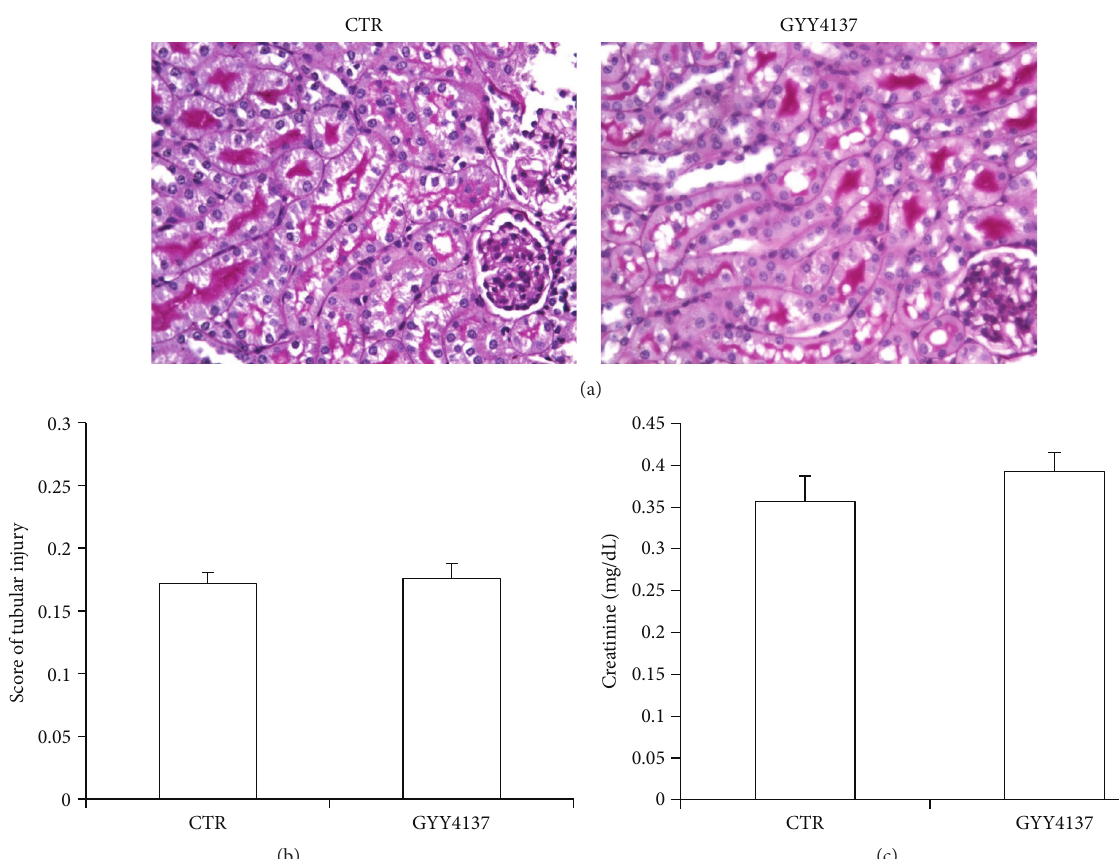
Figure 6: Effects of GYY4137 alone on renal morphology and function. (a) Representative images of periodic acid-Schiff staining ( × 400) of kidneys. (b) Tubular injury score. (c) Plasma creatinine levels. 𝑛 = 5 in each group. Data are means ±